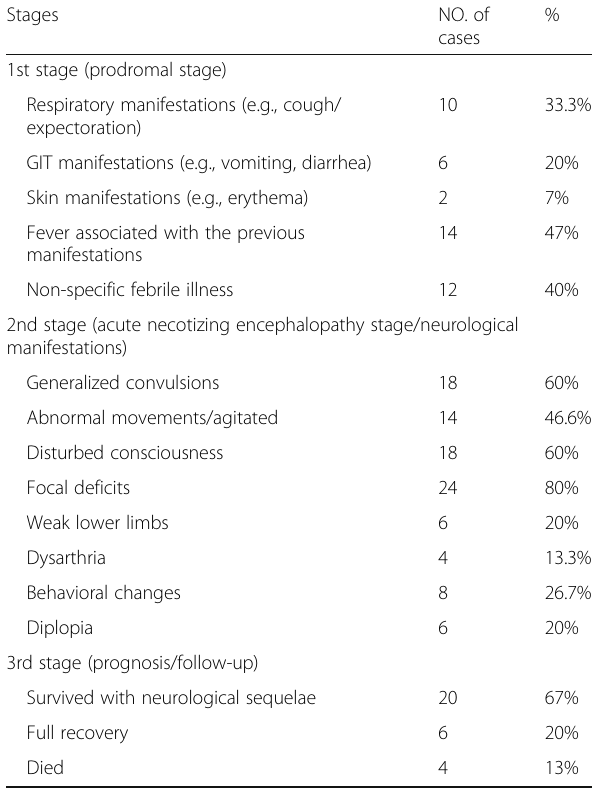
Table 1 Clinical characteristics of the children diagnosed with ANEC Stages NO. of